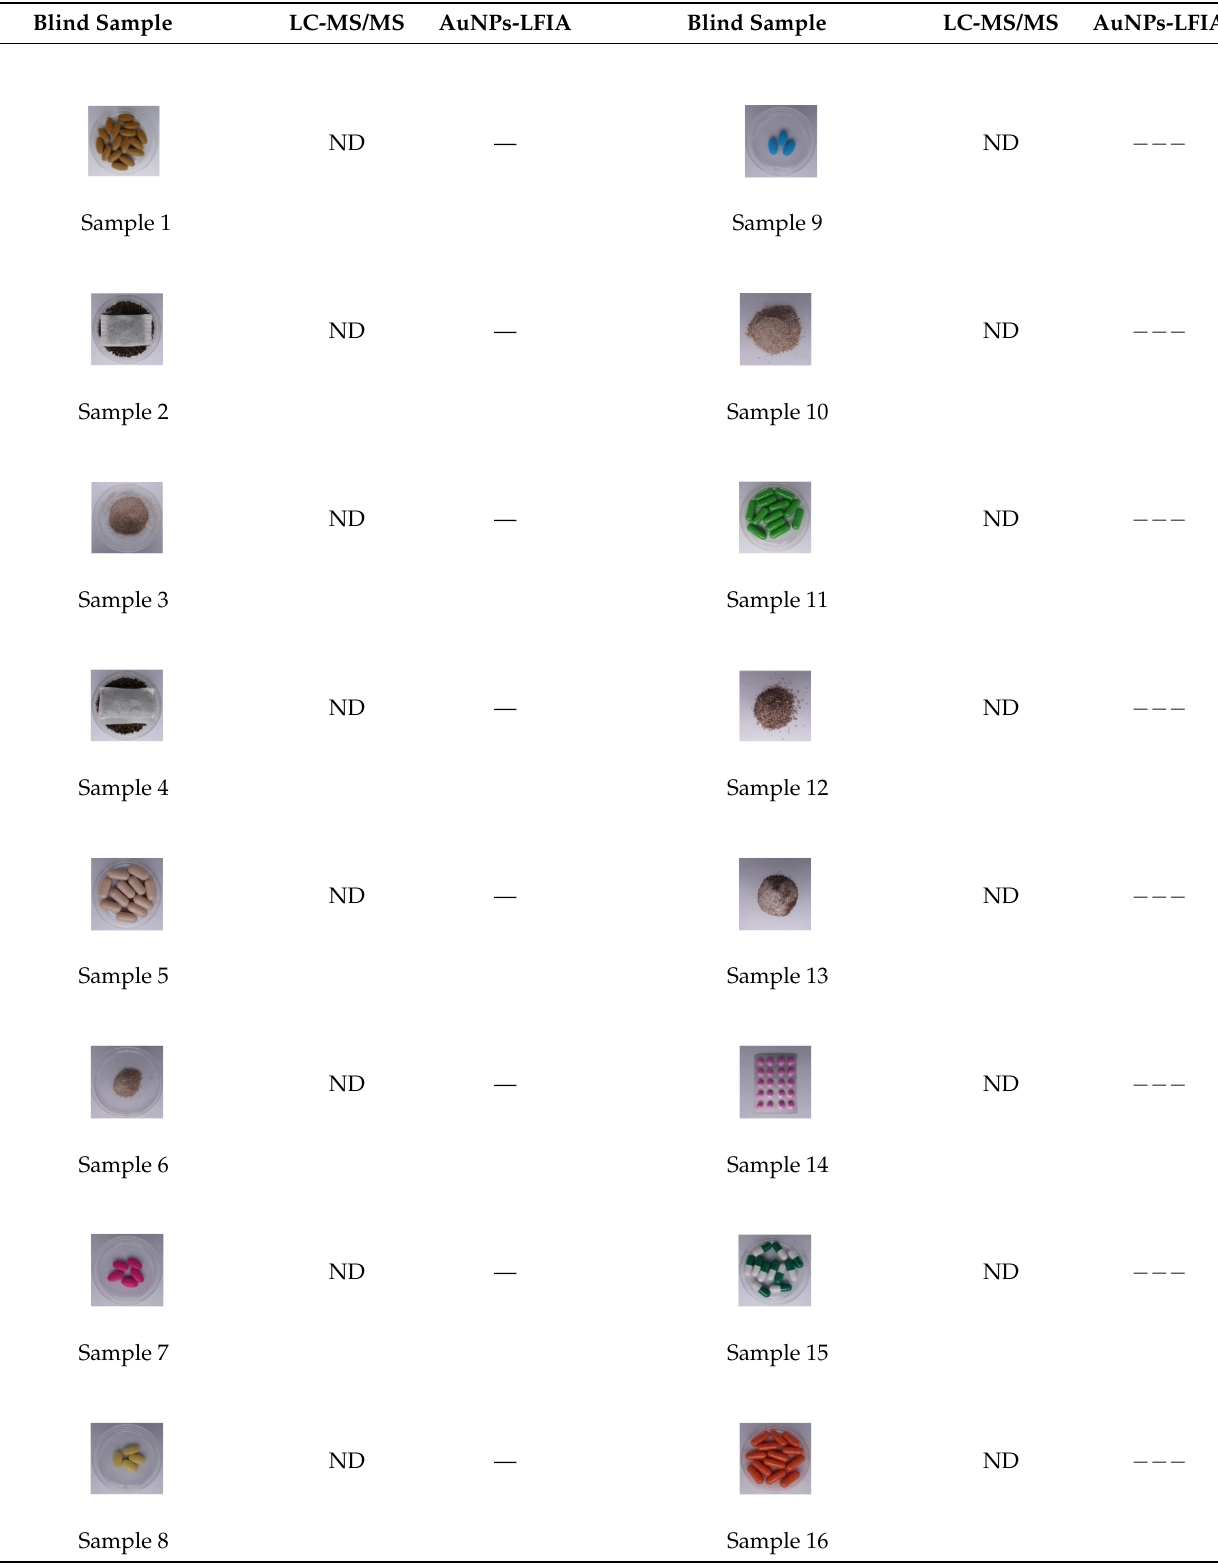
Table 2. Comparison of the detection results of the Au nanoparticles lateral flow immunochromatography (AuNPs-LFIA) and the liquid chromatography with tandem mass spectrometry (LC-MS/MS) in slimming health foods purchased in a Guangzhou market ( n =